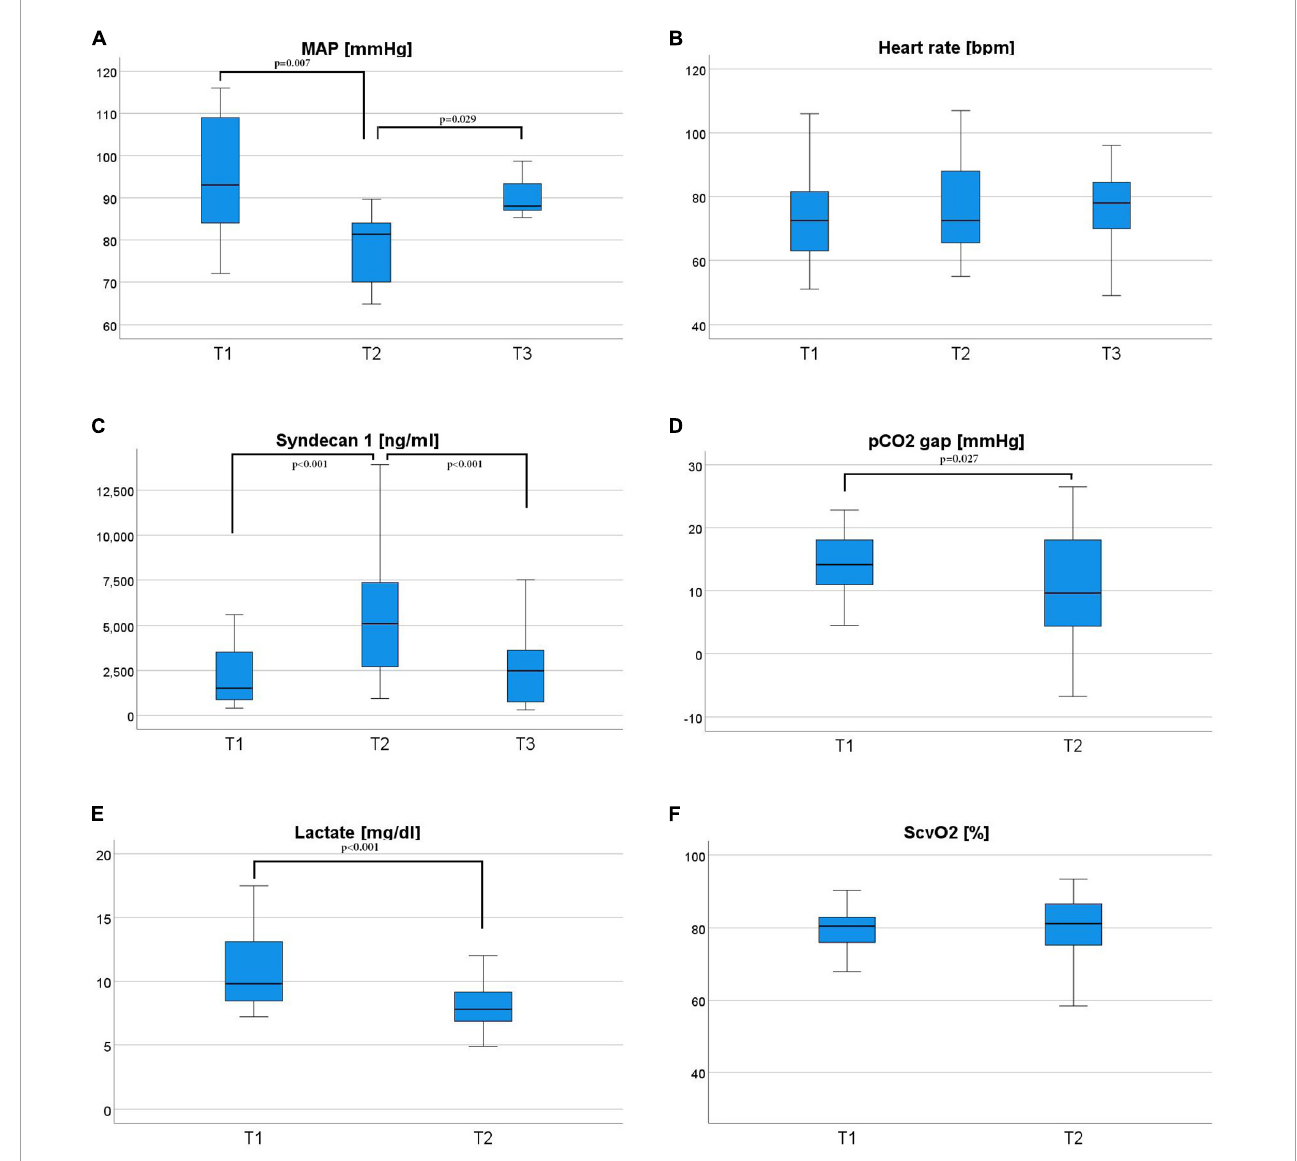
FIGURE3 The course of hemodynamic parameters over time; Mean arterial pressure (a MAP) (A) is given in millimeters of mercury (mmHg), heart rate (B) is given in beats per minute (bpm), Syndecan-1 (C) is given in ng/ml, carbon dioxide gap (pCO2 gap) (D) is given in millimeters of mercury (mmHg), lactate (E) is given in milligrams per deciliter (mg/dl) and the central venous blood oxygenation is given in percent. Parameters were measured at two or three timepoints: before valve replacement (T1), after valve replacement (T2), and (F) 3 days after valve replacement (T3) for MAP, HR, and Syndecan-1. Friedman-test was used for the statistical